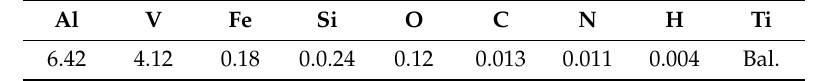
Table 1. Chemical composition (wt. %) of Ti6Al4V powders.